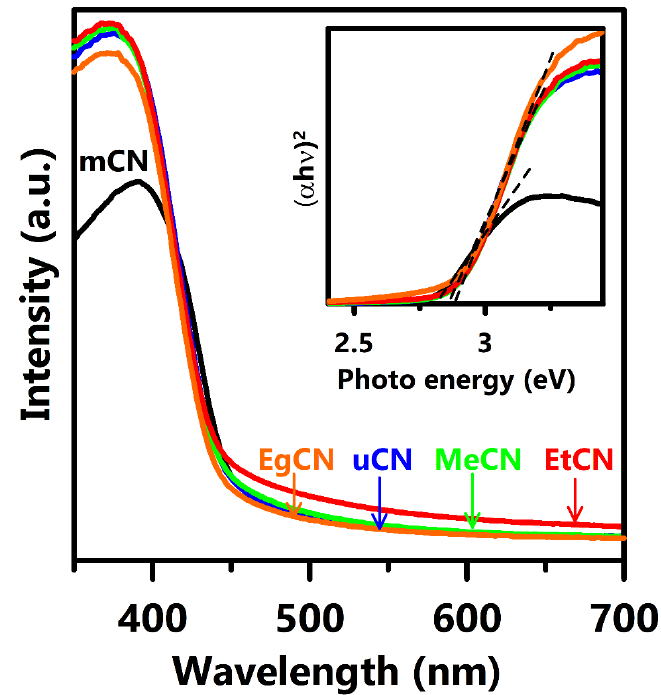
Figure 3 Figure 3. UV-vis spectra of mCN, uCN, MeCN, EtCN, and EgCN samples. Inset shows the Tauc plot of these samples. Polymers 2018 , 10 , x FOR PEER REVIEW